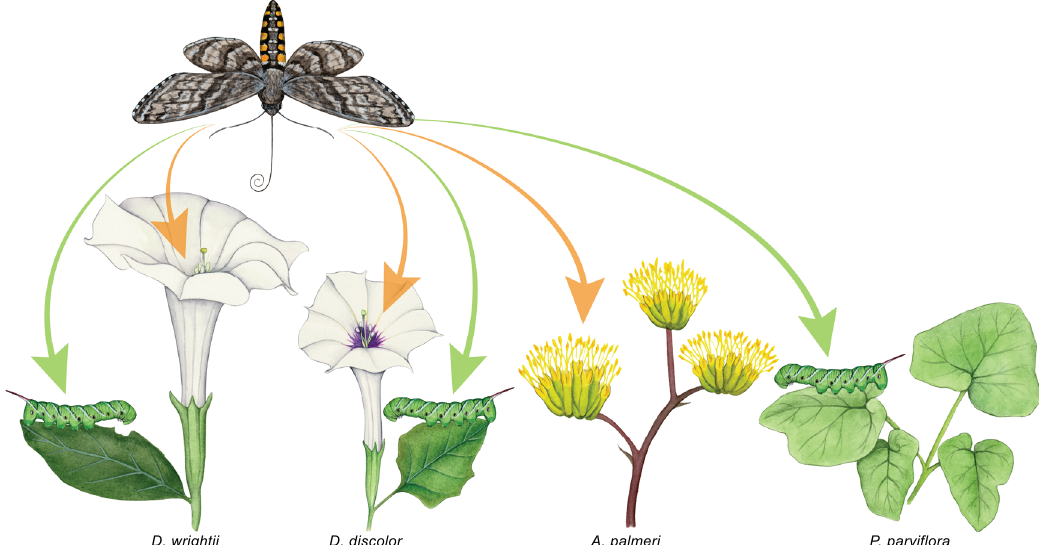
Fig. 1 Study system involving the hawkmoth Manduca sexta and its associated plants in southern Arizona, USA. M. sexta nectar-feeds (orange arrows) and oviposits (green arrows) at D. wrightii and D. discolor . The outcome of these interactions could be affected by M. sexta interactions with the alternative nectar source, A. palmeri , or the alternative larval host plant, P. parvi fl ora . Paintings by Julie Johnson (Life Science Studios).